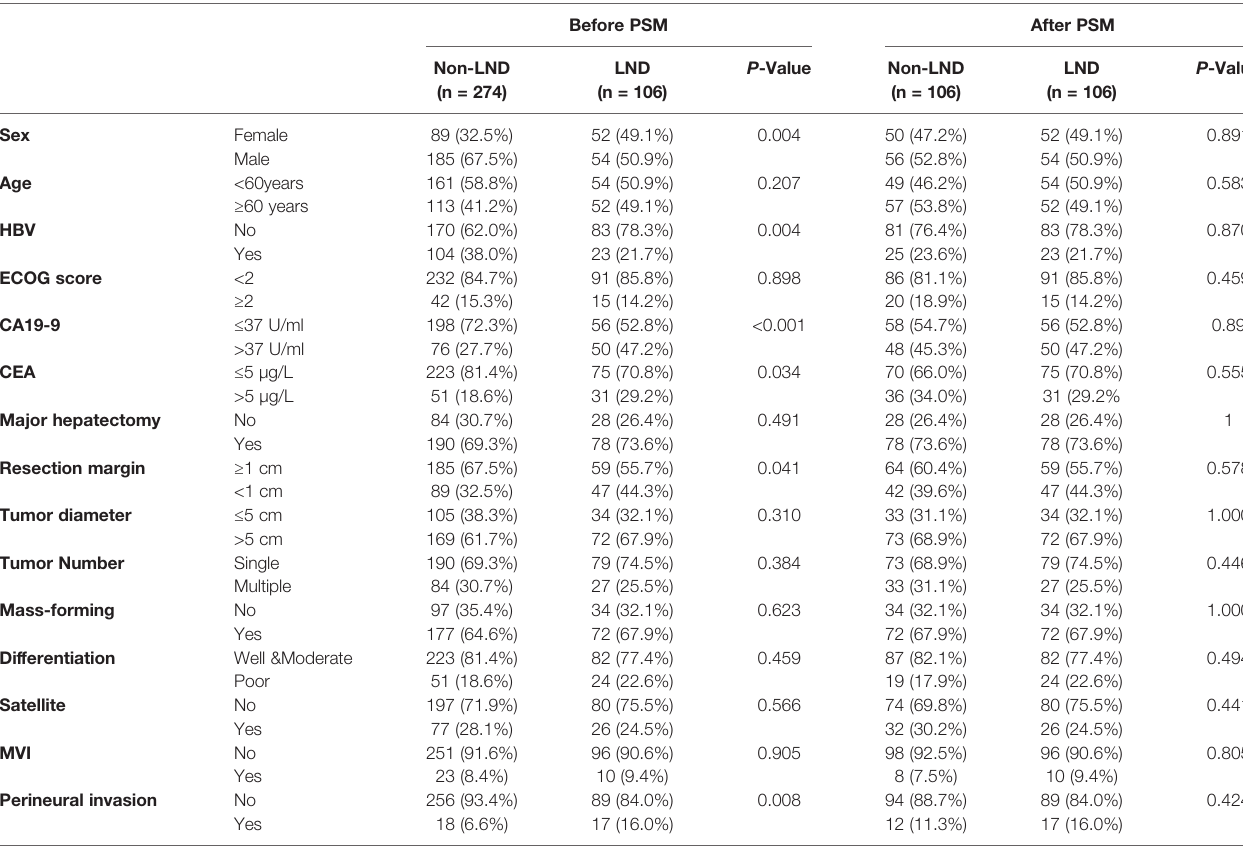
TABLE 1 | Clinicopathological characteristics before and after PSM.